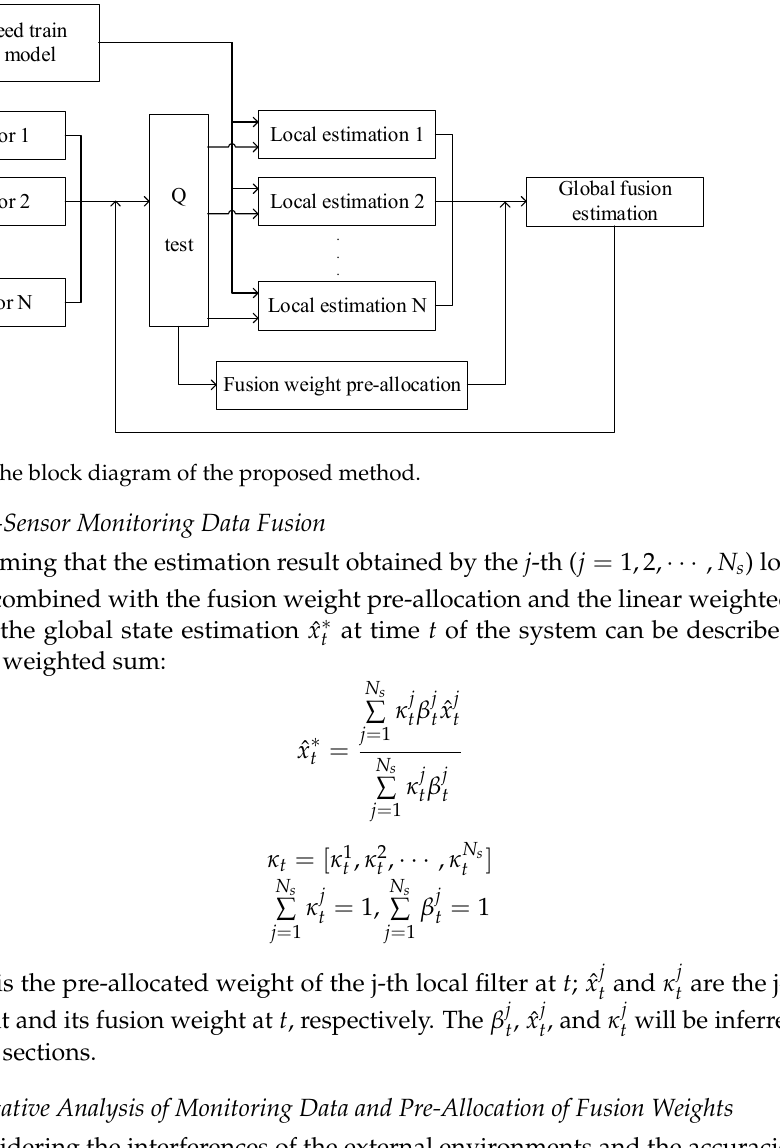
installation example.